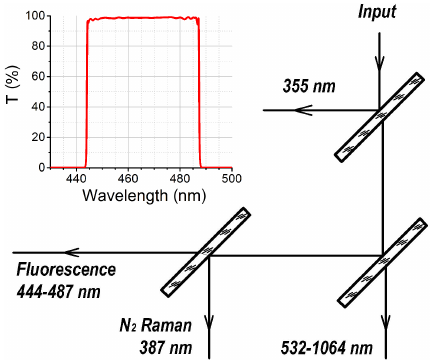
Figure 1. Optical scheme of the elastic, Raman and fluorescence backscatters’ separation together with the transmission curve of the interference filter in the fluorescence